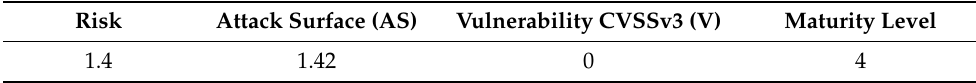
Table 26. IoT system mature levels.